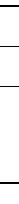
Table 1. Percentage of measurements per breed, pasture access (Past), measurement location (Loc), average milk yield (MY) and body weight (BW) for each survey stratification index (SSI)